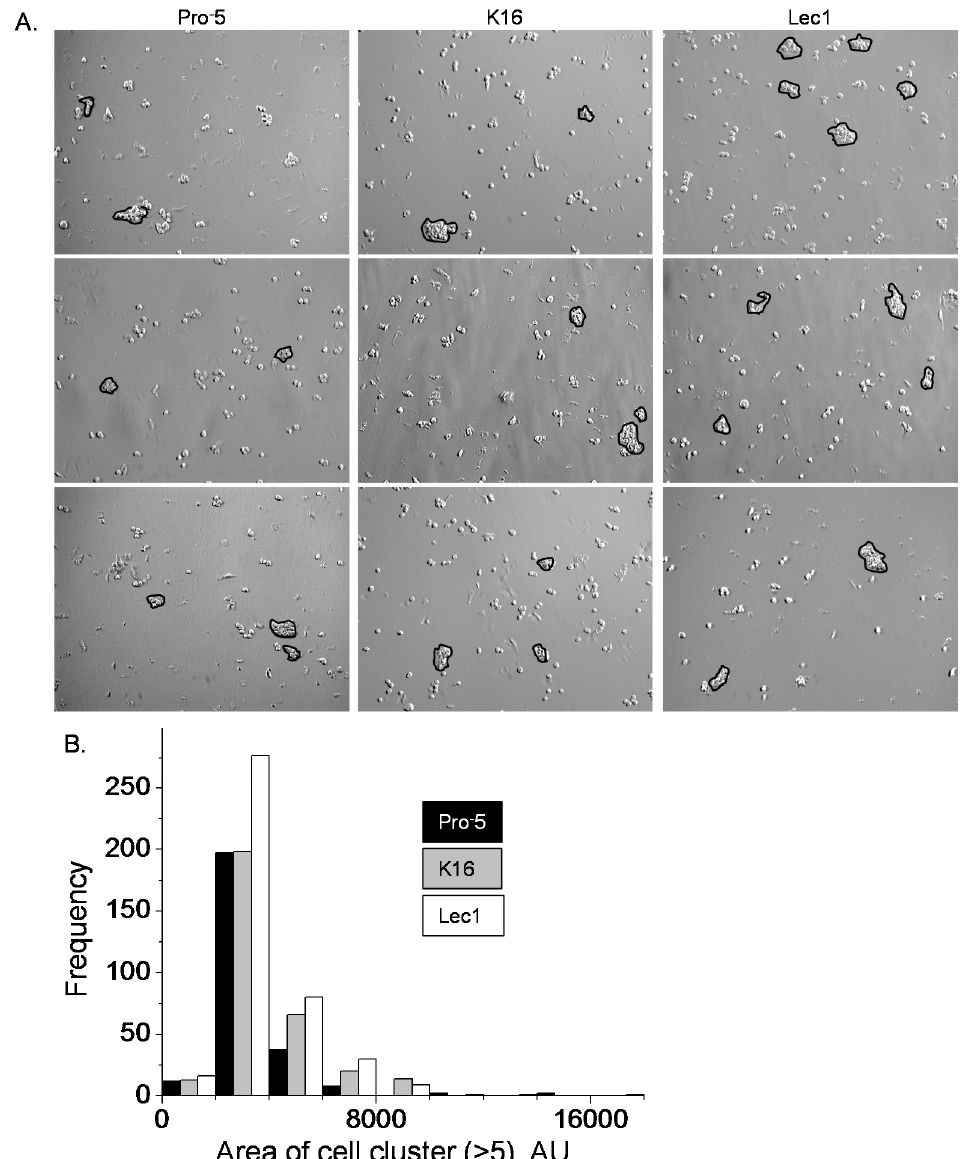
Figure 3. Type of N -glycan influences cell–cell adhesion. Microscopy images were acquired for Pro − 5, K16, and Lec1 cell lines ( A ); Particles (>5 cells/cluster) examined are encircled in black. The histogram represents the area of cell clusters from about 200 images for each cell line, as indicated ( B ), AU, arbitrary unit.